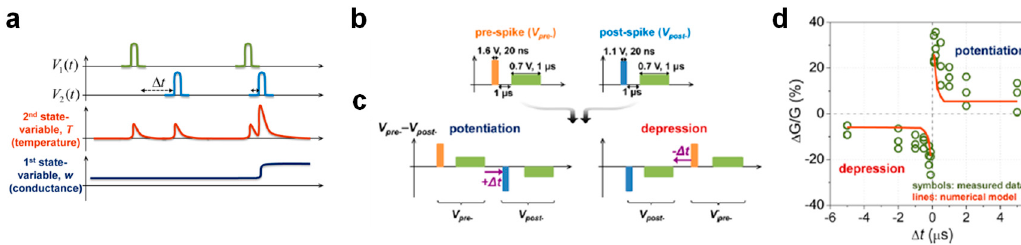
Figure 17. ( a ) Schematic representation of a non-overlap scheme enabling STDP in second-order memristors. Short-term memory e ff ects observed in second-order physical variables, e.g., internal temperature, allow for the implementation of potentiation / depression for short / long delays. ( b ) PRE and POST spike waveforms applied at top electrode (TE) and bottom electrode (BE) to implement non-overlap STDP. ( c ) E ff ective voltage across a second-order memristor to induce potentiation ( left ) and depression ( right ). ( d ) STDP characteristics measured in a second-order memristor against calculated curves achieved by numerical modeling. Reprinted with permission from [168]. Copyright 2015, American Chemical